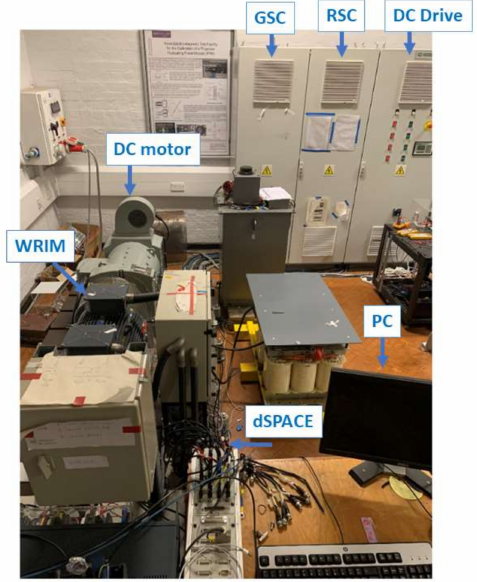
Figure 2. Overall picture of the laboratory test